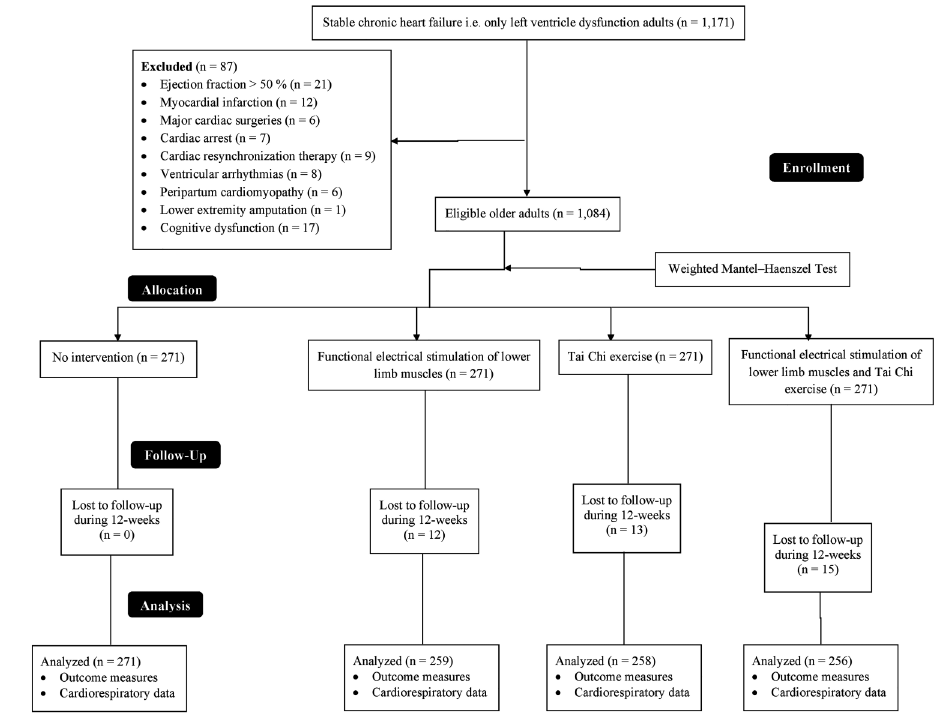
Figure 1. Flow diagram of the